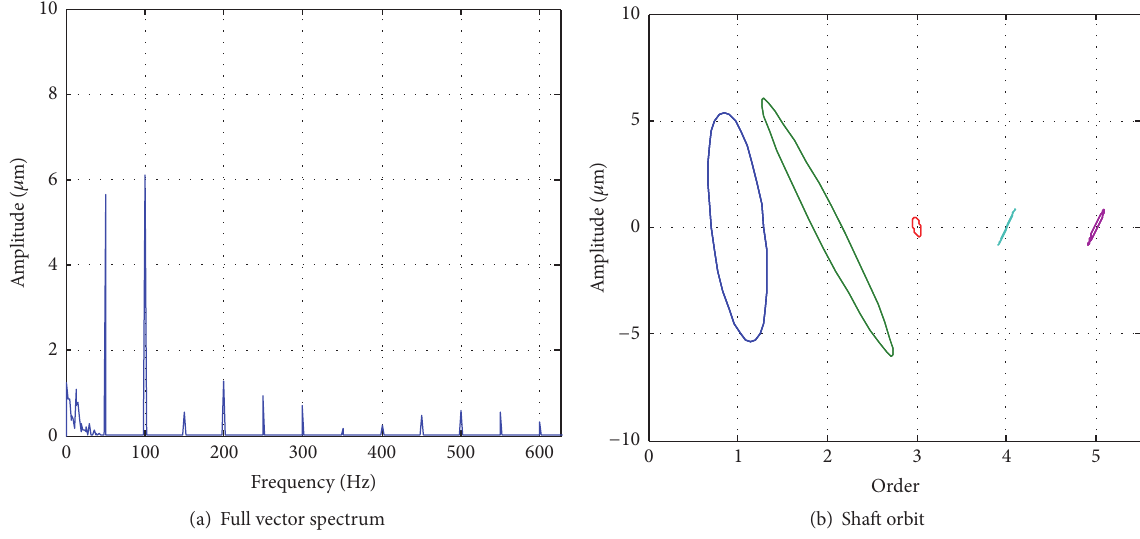
Figure 9: Full vector spectrum and shaft orbit.